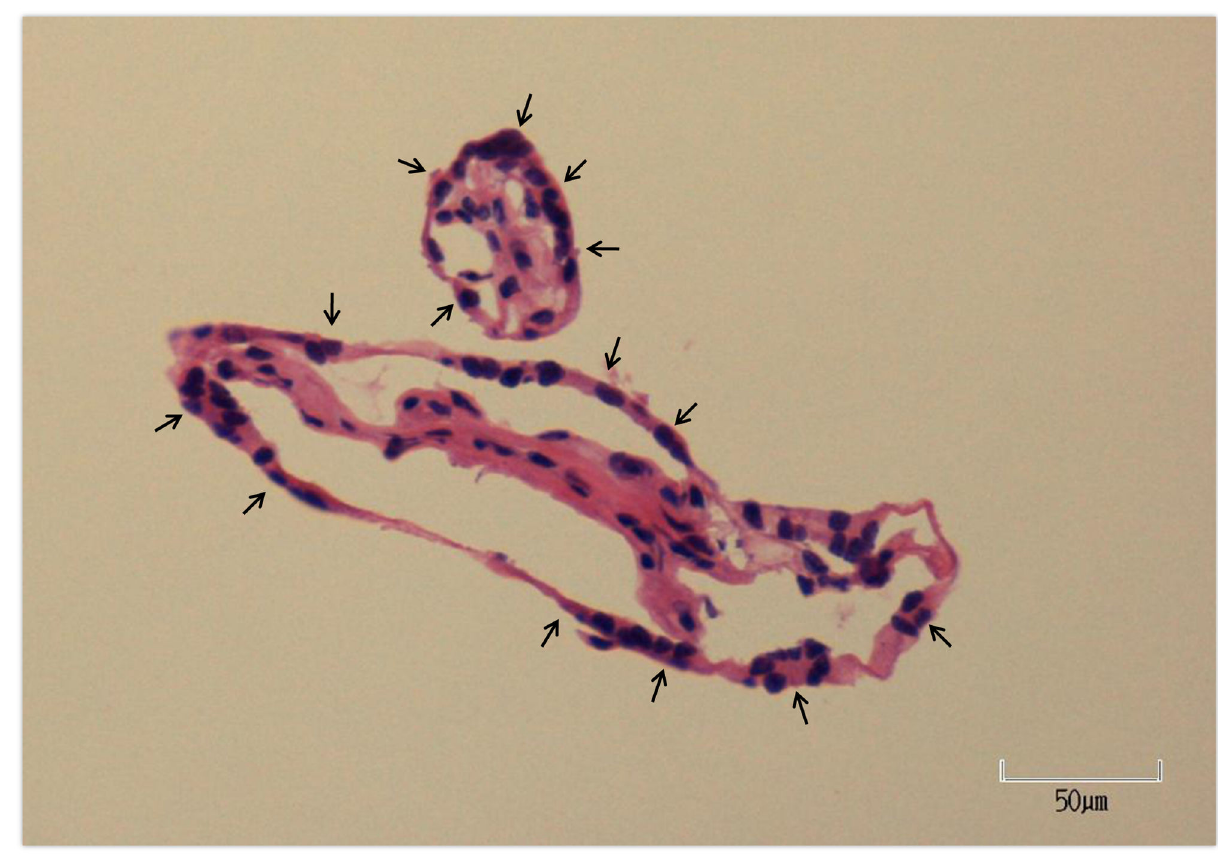
Figure 1. H&E staining of villous placenta. This is a H&E stained slide of normal term placenta shown at 20X magnification. Arrows indicate trophoblast